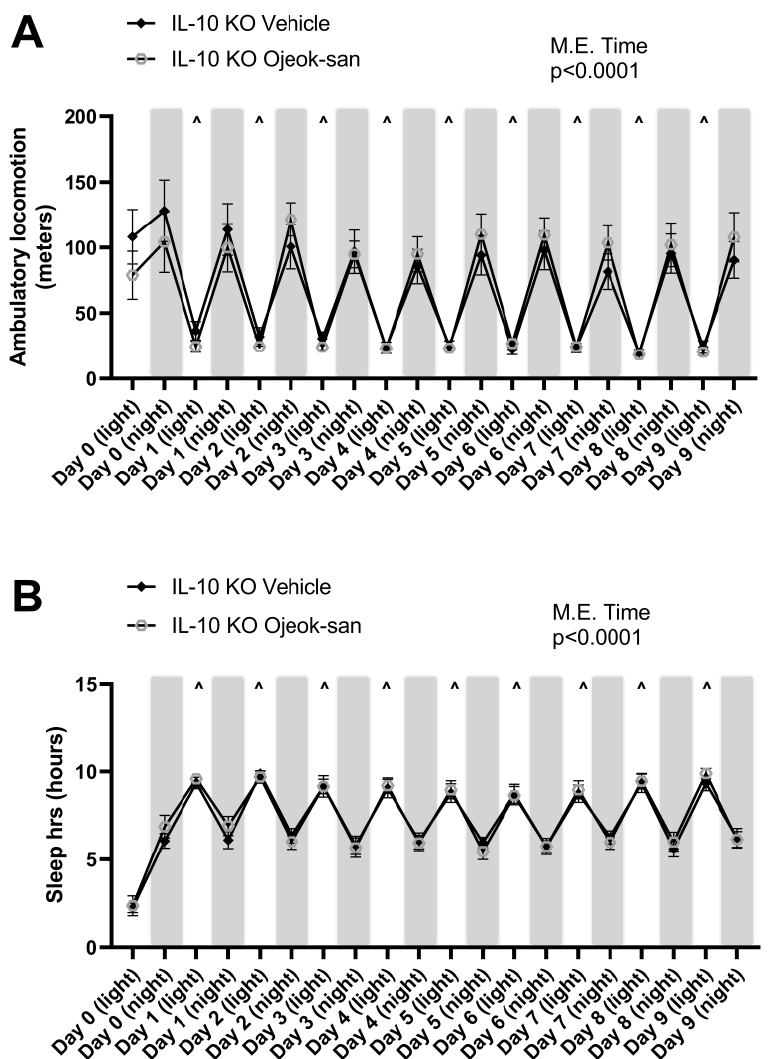
Figure 8. A single dose of OJS does not impact locomotor activity or sleep behavior in an IL-10 KO mouse model of spontaneous colitis. ( A ) Distance that IL-10 KO vehicle- and OJS-treated mice travelled in their home cage during the light and night cycle, ( B ) Time that the IL-10 KO vehicle- and OJS-treated mice spent sleeping during the light and night cycle. Values are represented as mean ± SEM; n = 8 mice per group. Two-way RM AVOVA. ˆ p < 0.05 Indicates statistical significance between night and light cycle.